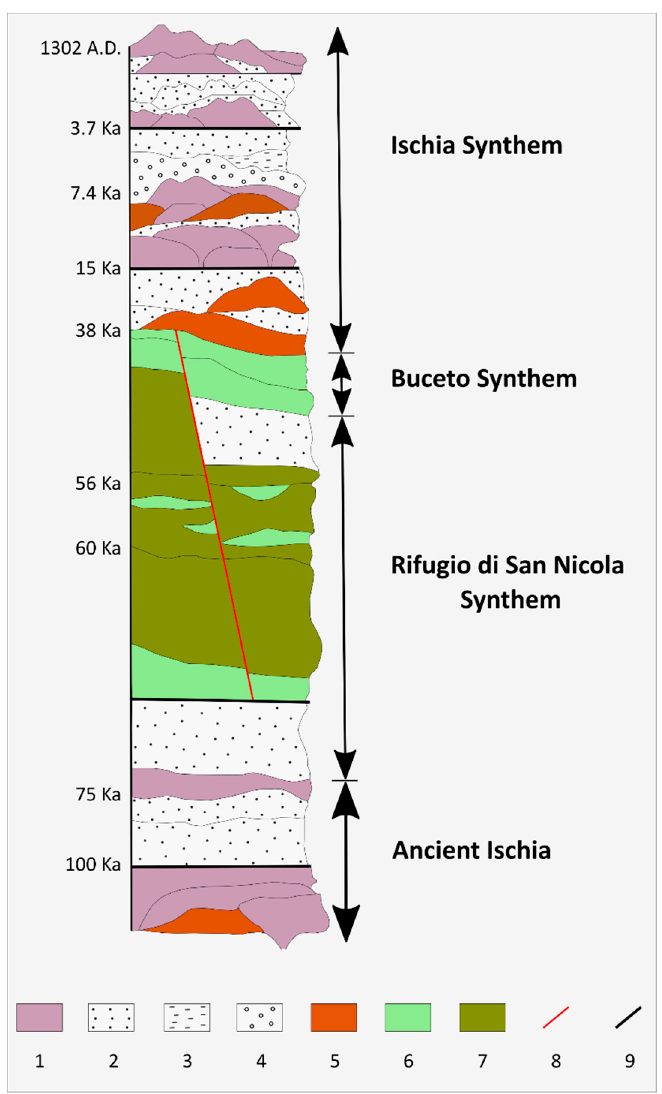
Figure 2. Simplified diagram of the stratigraphy of the island (modified from [11]): (1) lava flows, lava domes, breccias, and scoriae, (2) pumices, scoriae, bombs, and ashes, (3) marine sands and silty sands, (4) debris flow and mudflow deposits, (5) ash tuffs, (6) epiclastic deposits and marine sediments, (7) ash-flow tuffs, ashy and pumiceous tuffs (Mt. Epomeo Green Tuff Auctt., pro parte), (8) fault, (9) unconformity.